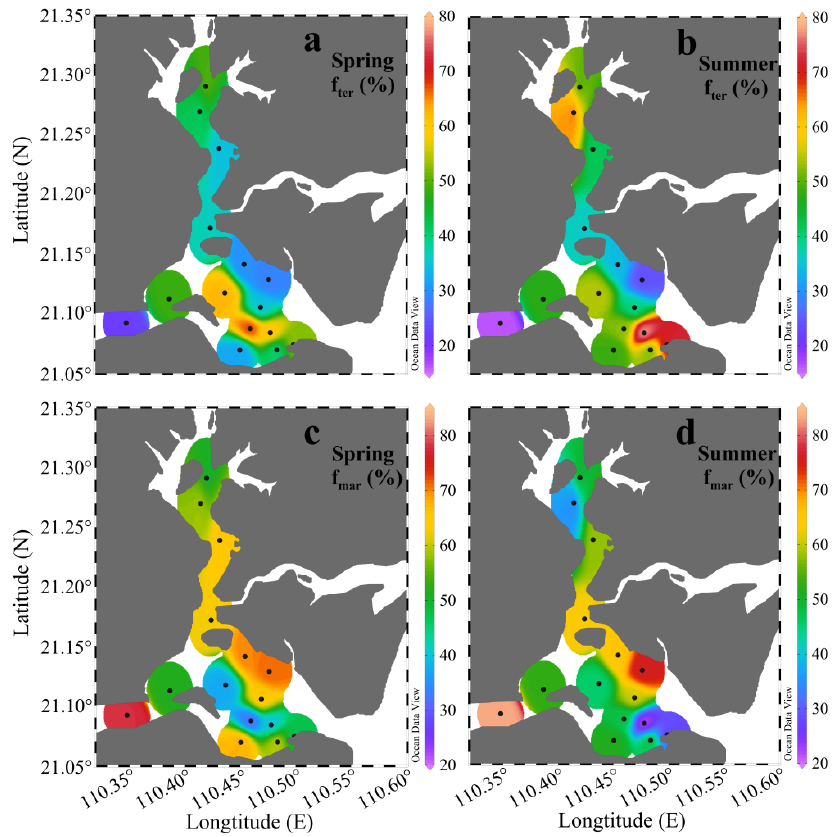
Figure 6. The percentage distribution of terrestrial (f ter ) and marine (f mar ) organic matter in the surface sediments of Zhanjiang Bay in spring and summer. ( a ): the percentage distribution of terrestrial organic matter in spring; ( b ): the percentage distribution of terrestrial organic matter in summer; ( c ): the percentage distribution of marine organic matter in spring; ( d ): the percentage distribution of marine organic matter in summer.